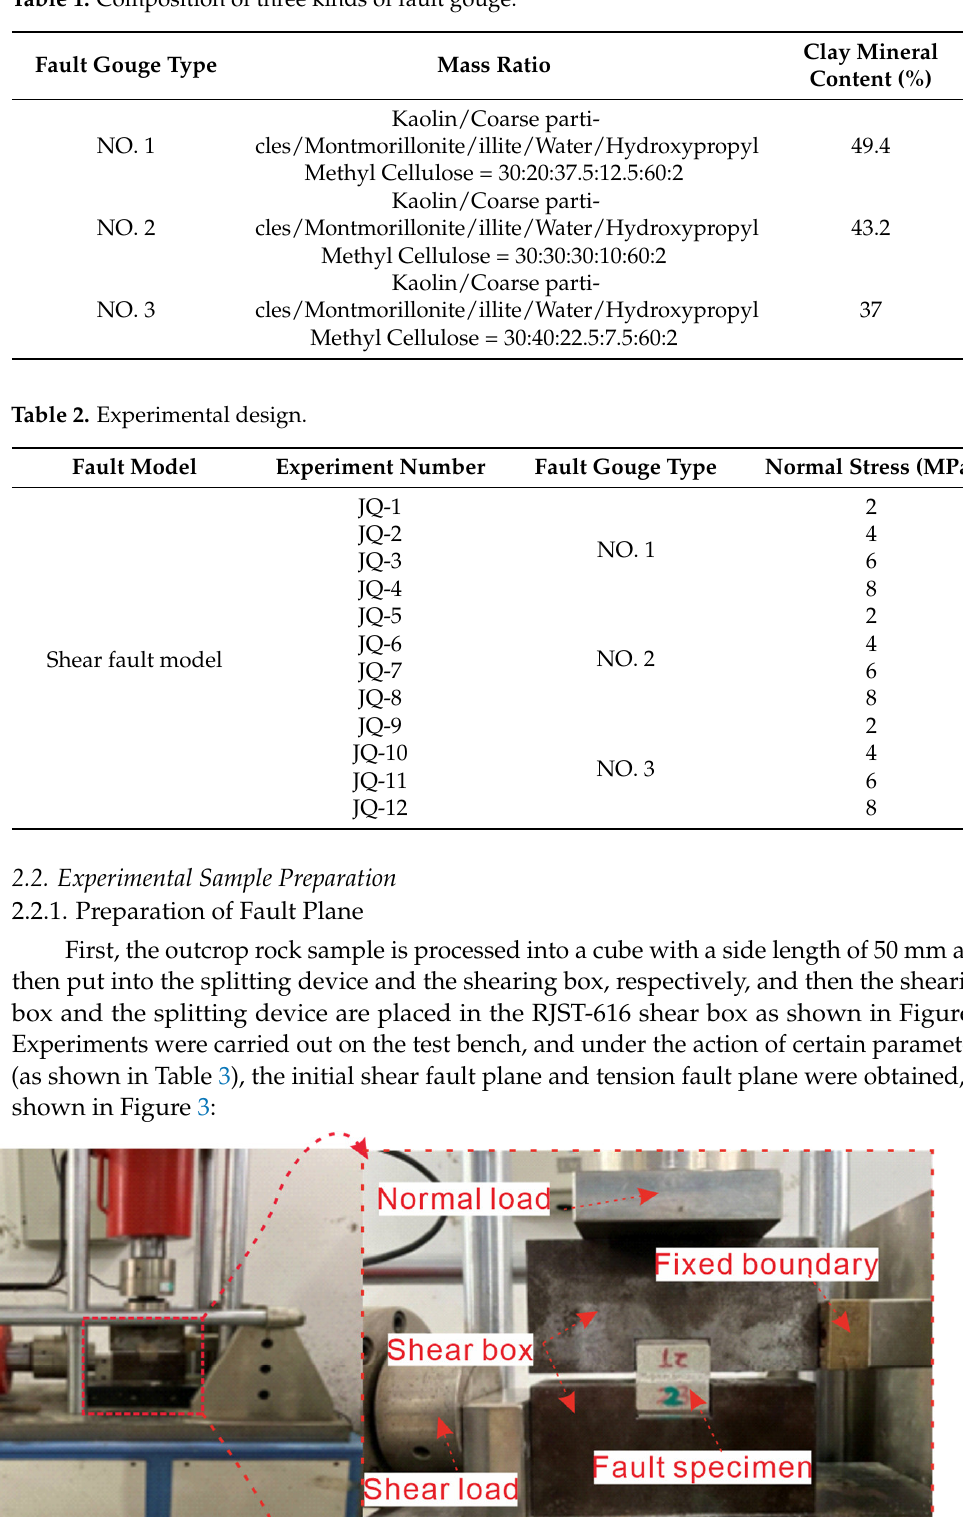
Table 1. Composition of three kinds of fault gouge.